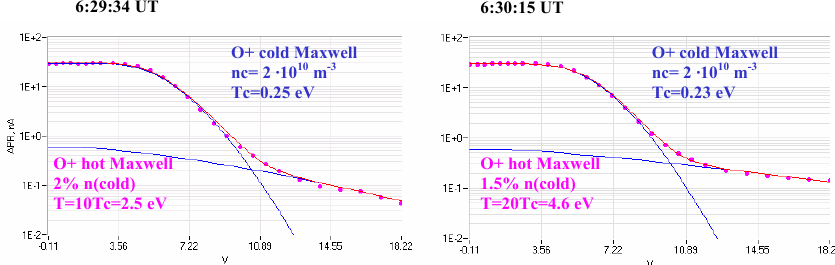
Fig.7 Fig. 7. Current distribution versus potential applied to the retarding grid measured by APR shows two populations of the O + species, i.e. cold and warm. Moments of observations are indicated by arrows in Fig. 5. Temperature of the warm population is gradually increased inside the SAPS boundary layer.